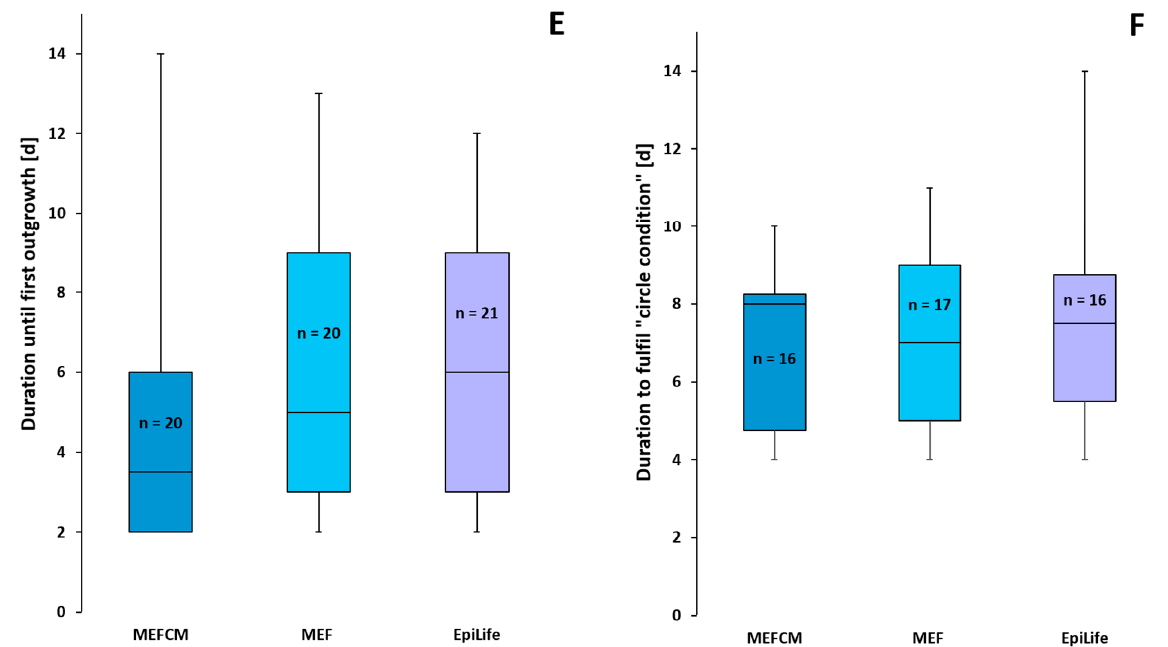
Figure 4. Influence of different culture media on keratinocyte outgrowth from HFs. Relative outgrowth of keratinocytes from HFs after cultivation in five different media (MEFCM, MEF medium, EpiLife medium, DK-SFM, KGM2) after <2 h ( A ), 24 h ( B ), 48 h ( C ) and 7 d ( D ) in DMEM transportation media. Both commercially available media DK-SFM and KGM2 showed the lowest outgrowth rate. Three different media (MEFCM, MEF medium, EpiLife medium) were compared for the time period until the first keratinocytes appear ( E ) and the time to fulfil the circle condition ( F ). Significance is indicated via asterisks (Chi2 test (1) = 16.3, p < 0.001). p -value: p < 0.001 ***. N = number of single, independent experiments.